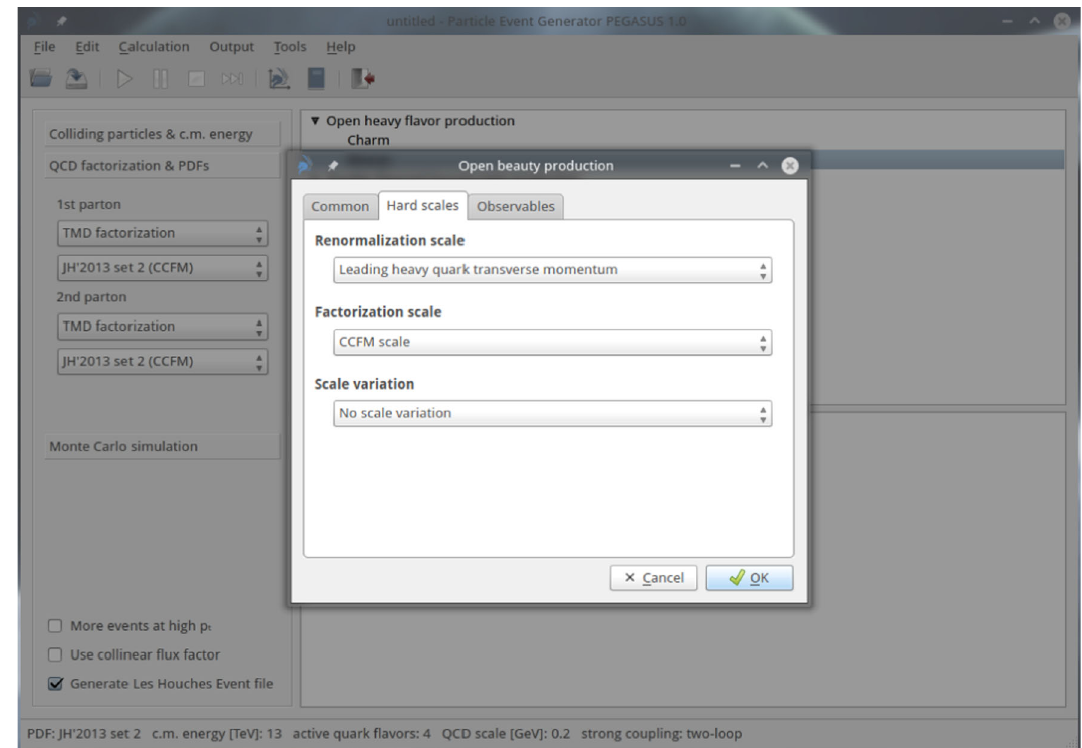
Fig. 3 One can optionally correct the default kinematical restrictions, list of requested observables and corresponding binnings for any processes (part 2)